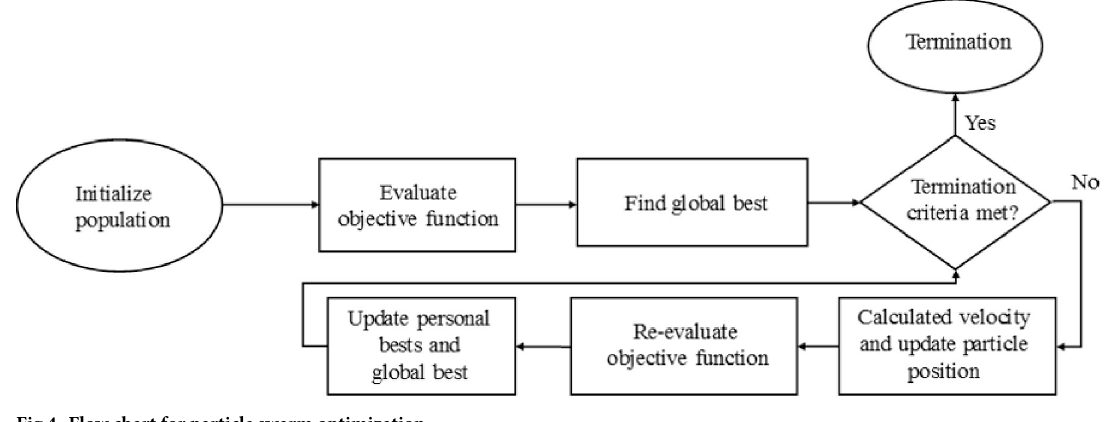
Fig 4. Flow chart for particle swarm